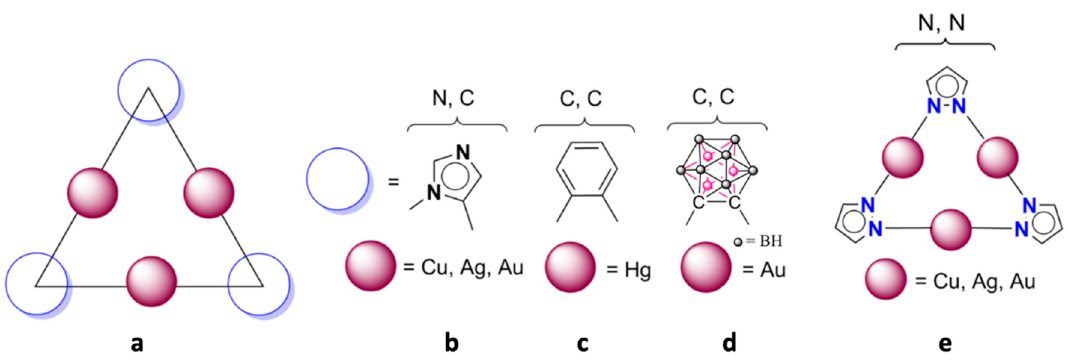
Figure 1. Structure of the studied compounds. ( a ) General structure, full red circles the metal; empty blue circles the ligand. ( b ) Imidazolate ligands linked by N and C atoms. ( c ) Phenylene ligands linked by C atoms. ( d ) 1,2-Dicarba-closo-dodecaborane ligands linked by C atoms; the structure of 1,2-dicarba-closo-dodecaborane was simplified. ( e ) Pyrazolate ligands linked by N atoms.